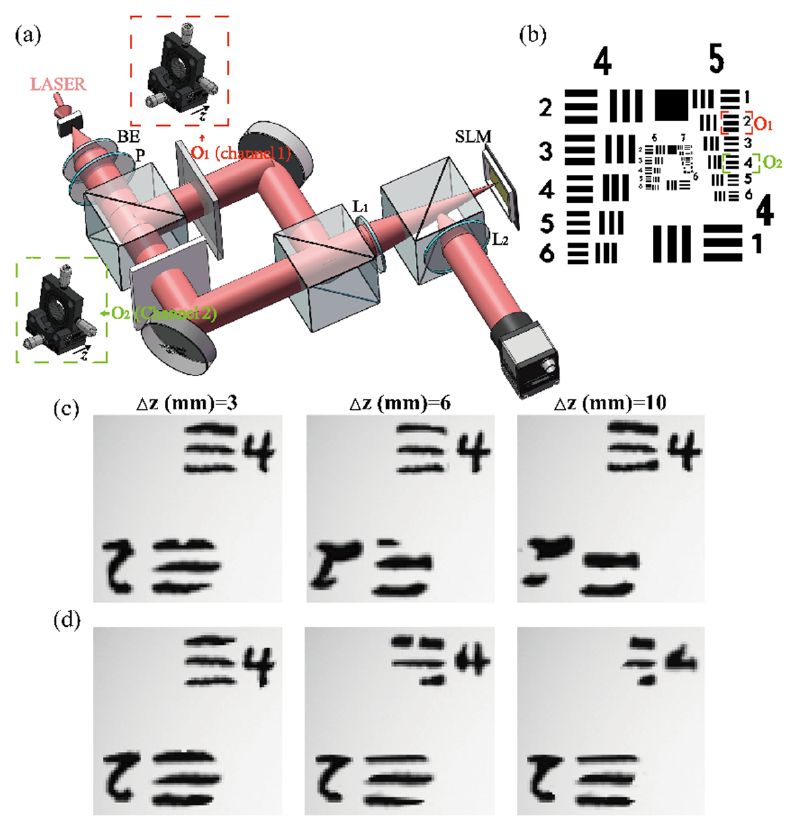
Figure 12. Demonstration of the 3D imaging reconstruction process of the proposed method by the separation between two planes Δ z. ( a ) Optical system configuration (BE: beam expander. P: polarizer. L1, L2: lens. SLM: spatial light modulation); ( b ) Uncropped object by the proposed strategy; ( c ) Reconstruction using CPM2 of O 2 plane; ( d ) Reconstruction using CPM1 of O 1 plane.